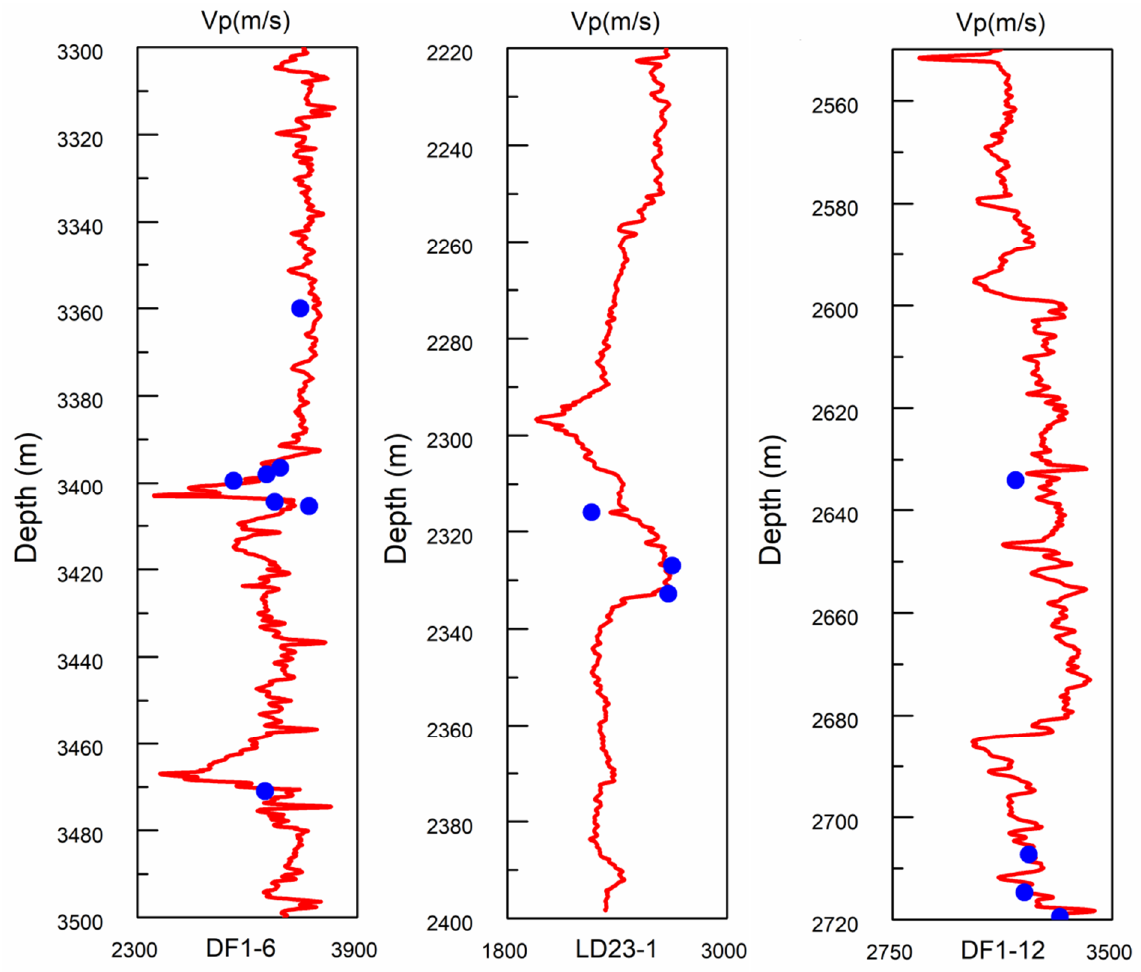
Figure 16. P-wave velocity prediction of the three wells (blue dots are the prediction data).